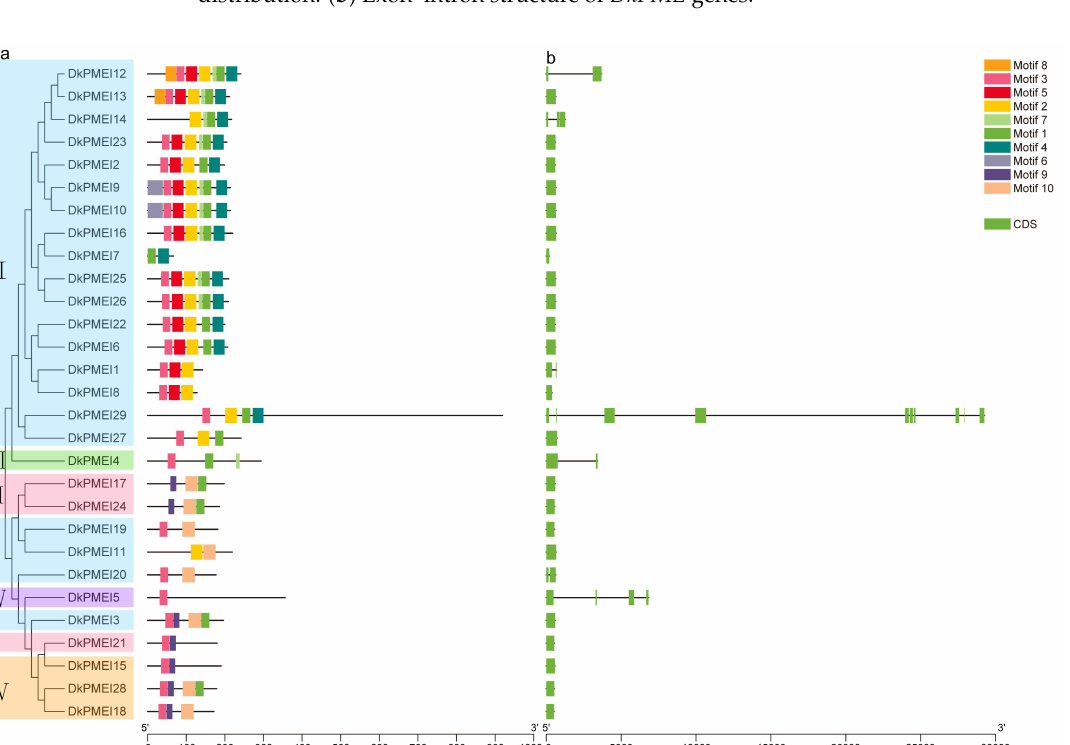
Figure 2. Conserved motif and gene structure analyses of PME genes in D. kaki . ( a ) Conserved motif distribution. ( b ) Exon–intron structure of DkPME genes.